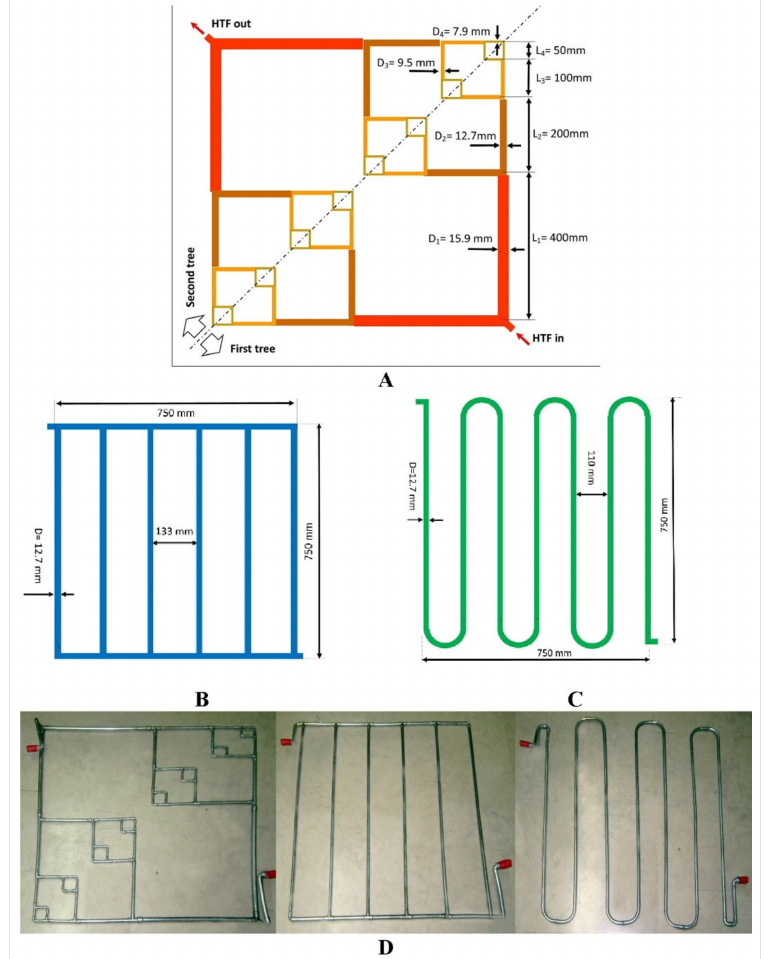
Figure 5. Different designs of heat exchangers: ( A ) novel design; ( B ) parallel channel; ( C ) serpentine design; ( D ) different designs of heat exchanger [62].